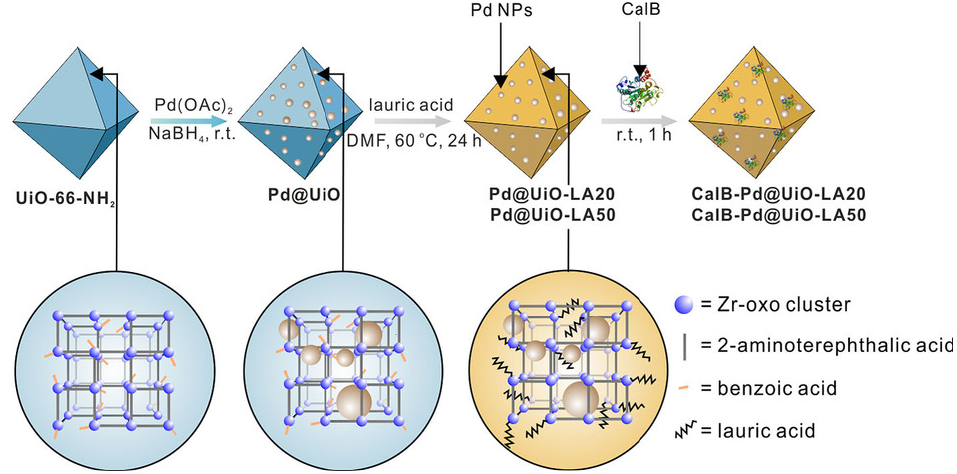
Figure 9. Preparation of a MOF-based CAL-B/Pd catalyst [180]. Reprinted from [180] with permis- sion of John Wiley and Sons.